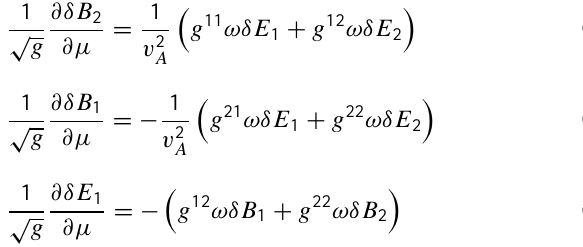
Fig. 2. Three-dimensional view of a compressed dipole (cid:2)eld lines with B 0 = 31000 nT, b 1 = 10 nT, b 2 = 8 . The color code shows the equatorial magnetic (cid:2)eld intensity. The sphere represents the Earth ( r = 1 ).